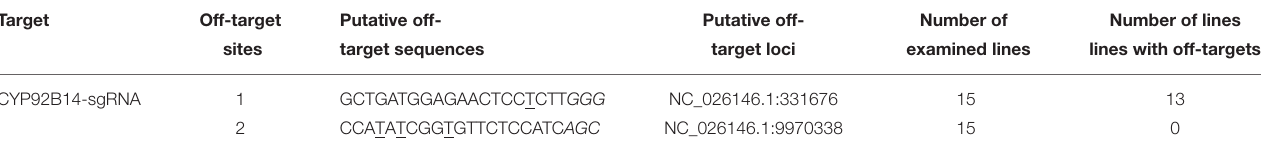
TABLE 3 | Analysis of mutation in potential off-target